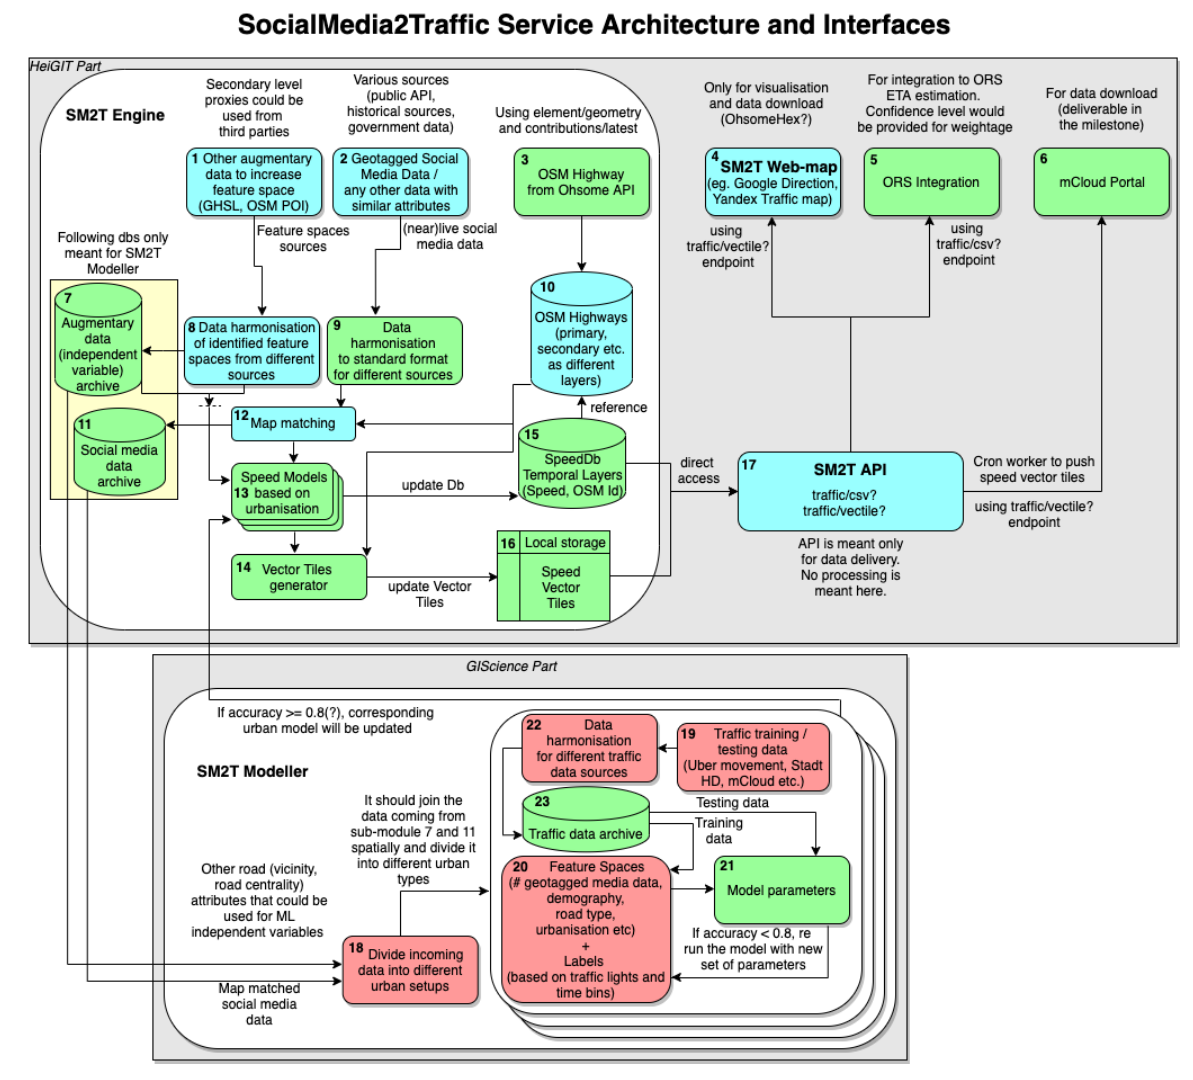
Figure A1. SM2T architecture and